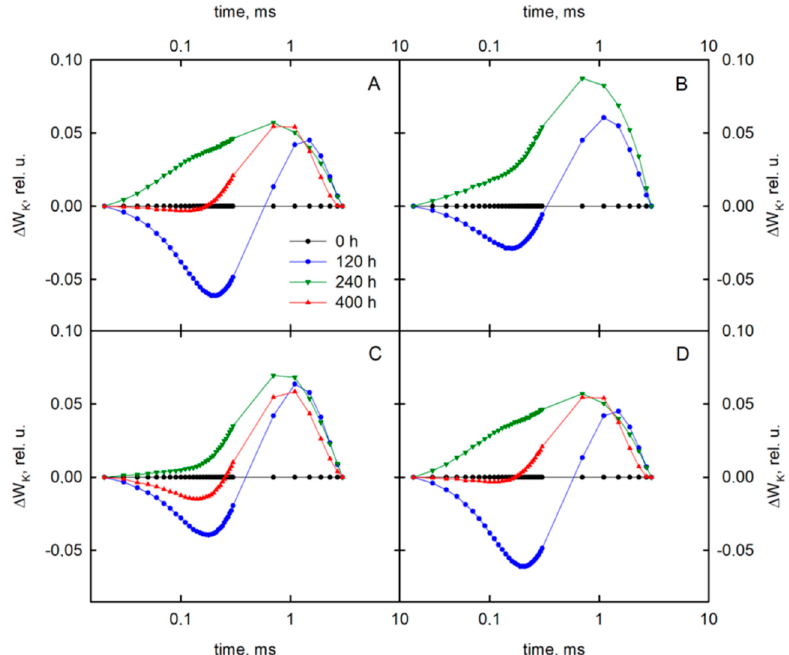
Figure A1. Differential curves of Δ W K (obtained by subtracting the control curve from the first sample in the time from 0.02 to 3 ms) of perennial ryegrass varieties (Roadrunner and Nira) under different field water capacity of soil (50 and 30% FWC) and time (0, 120, 240 and 400 h after stress application): ( A ) Roadrunner under 50% FWC, ( B ) Roadrunner under 30% FWC, ( C ) Nira under 50% FWC, ( D ) Nira under 30% FWC. n = 6. Relative units.